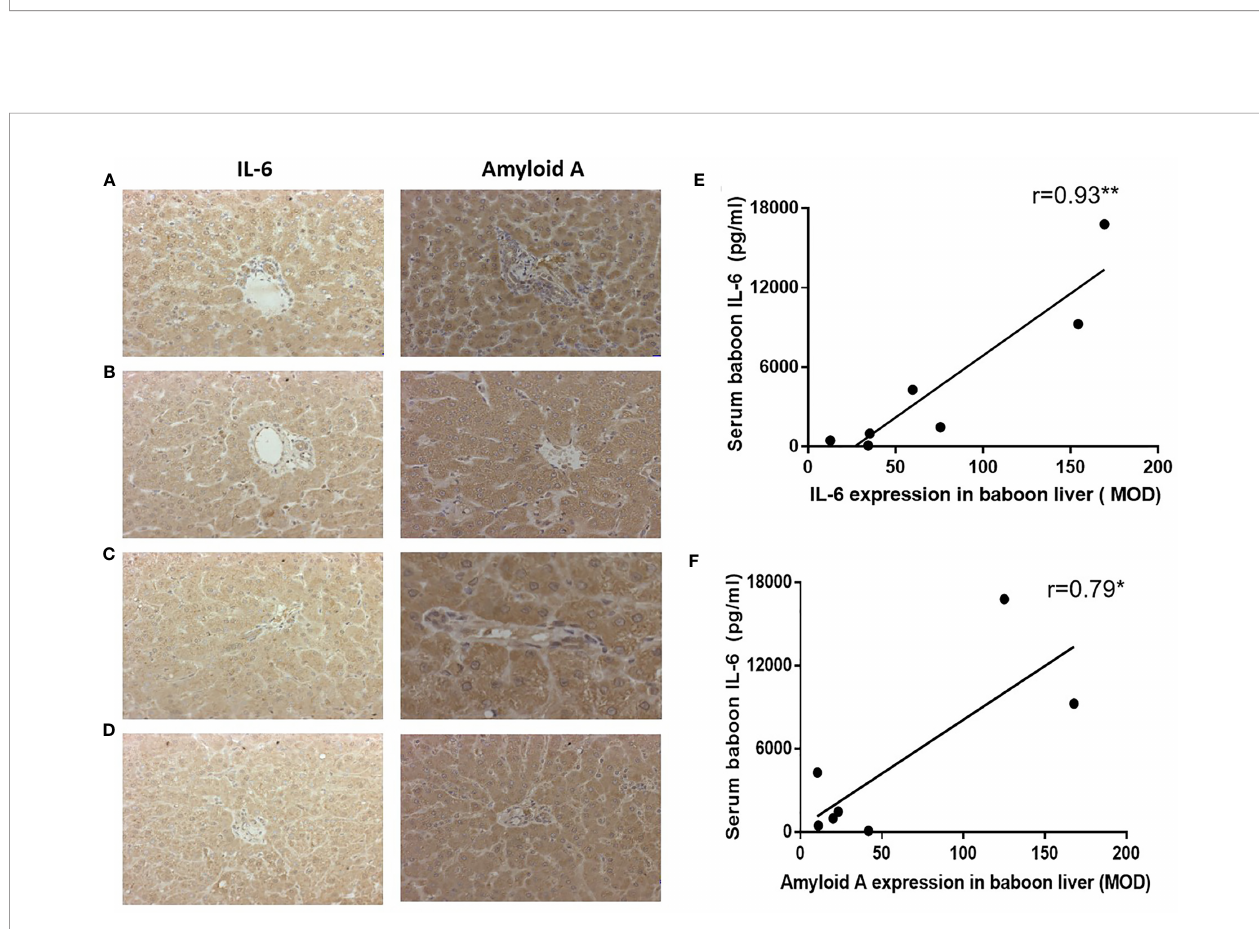
FIGURE 7 | Expression of IL-6 or amyloid A in baboon livers detected by IHC, and correlation with serum baboon IL-6 levels. (A) Expression of IL-6 and amyloid A in the liver of a baboon that experienced anaphylactic shock (without transplantation) (positive control), (B) Expression of IL-6 and amyloid A in the liver of a baboon with a pig kidney graft that underwent hyperacute rejection (while receiving tocilizumab and etanercept) (positive control). (C) Expression of IL-6 and amyloid A in the liver of a representative baboon with a pig kidney graft that was undergoing antibody-mediated rejection (while receiving tocilizumab and etanercept). (D) Expression of IL-6 and amyloid A in the liver of a representative baboon with a pig kidney graft that was undergoing serious infection (while receiving tocilizumab and etanercept). (E, F) Signi fi cant positive correlations were found between serum baboon IL-6 levels and expression of IL-6 (**p < 0.01) or amyloid A (*p < 0.05) in baboon